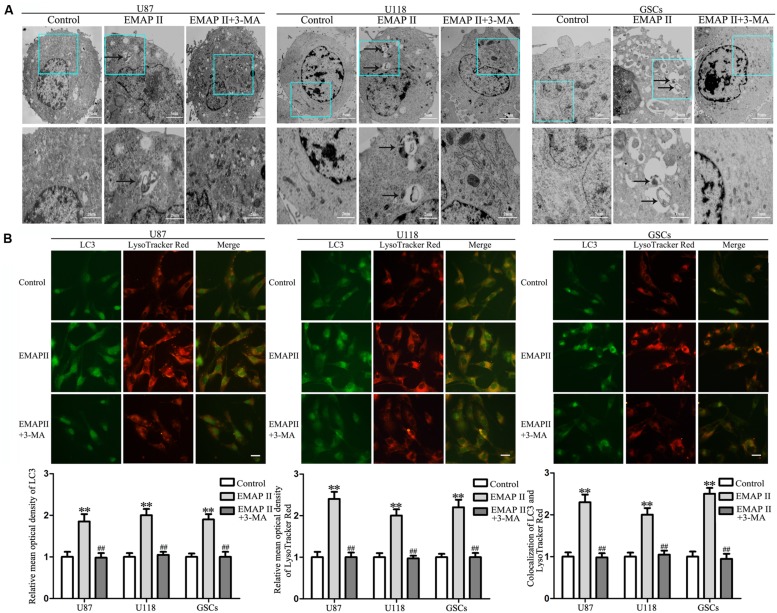
Effect of EMAP II and 3-MA on the ultrastructural change in human GBM cells and GSCs. (A) Effect of EMAP II and 3-MA on the ultrastructural change in U87, U118, and GSCs. Arrows show autophagic vacuoles. (B) The colocalization of LC3 and LysoTracker Red in U87, U118, and GSCs. Relative mean optical density of LC3 and LysoTracker Red, and the co-localization of LC3 and LysoTracker Red quantified. Pictures are respective magnification (n = 4, each). Scale bar = 20 μm. ∗∗P < 0.01 vs. control group, ##P < 0.01 vs. EMAP II group.